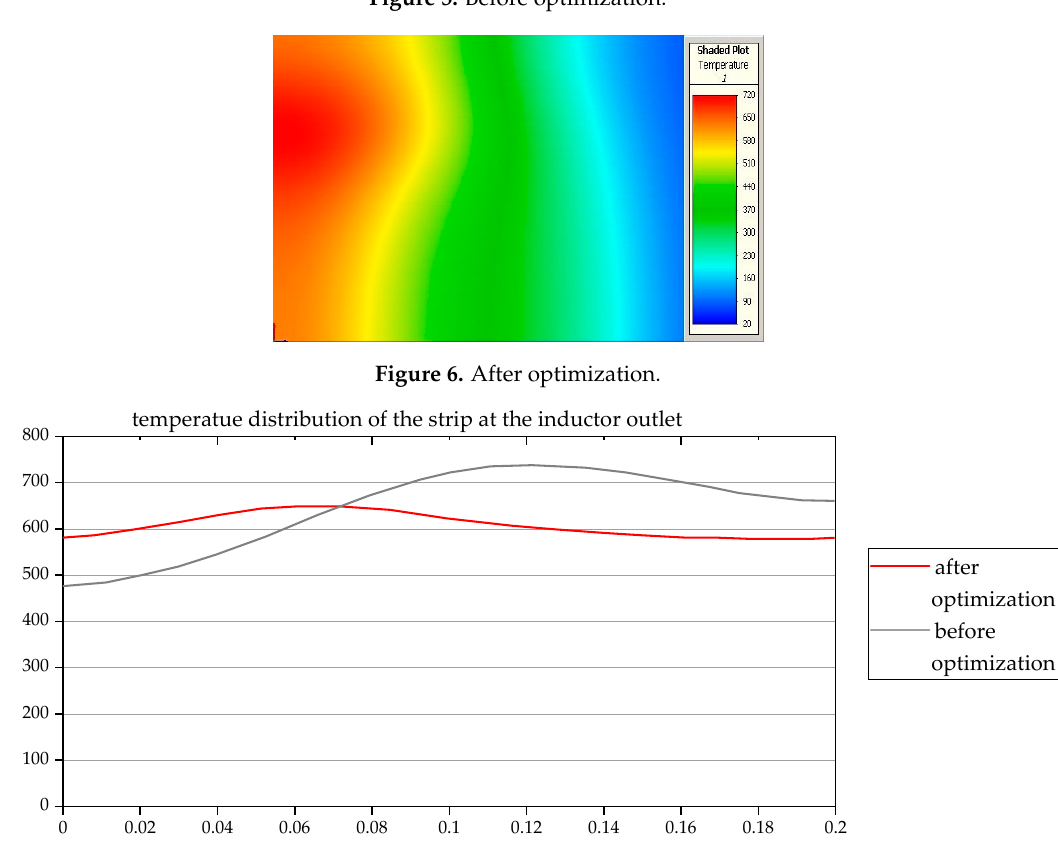
Figure 5. Before optimization.